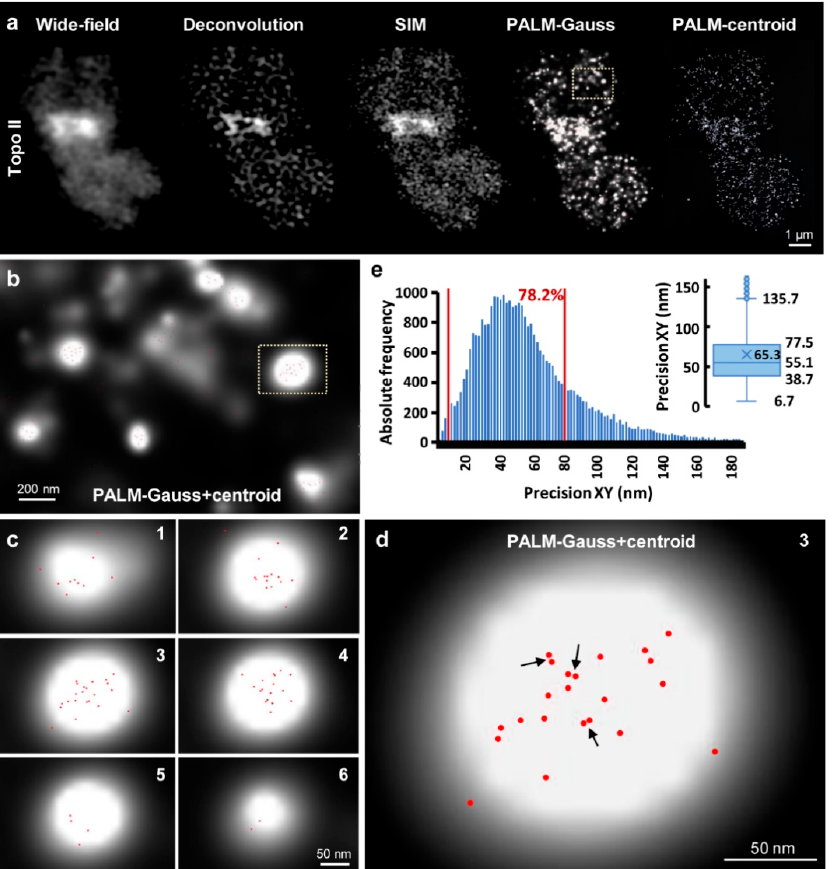
Figure 4. Photoactivated localization microscopy (PALM) allows detecting single Topo II molecules with an XY-precision of up to ~5 nm. ( a ) Visualization of Topo II by wide-field, deconvolution, SIM, and PALM using secondary Alexa488-labeled antibodies in a single 3D image stack slice. The PALM-centroid view indicates the localization of single molecules present in a single PALM image slice of 20 nm thickness. ( b ) Enlarged region (dashed rectangle in ( a ) showing the distinct accumulation of several molecules (indicated by centroids) within PALM-Gauss spots. ( c ) In the six consecutive slices of a further enlarged spot (dashed rectangle in ( b ) differently localized molecules per slice appear. The Z precision reached up to ~45–50 nm (see Figure S3). ( d ) In slice 3 centroid pairs even if ~5 nm apart (arrows) can be distinguished and hence Topo II molecules can be counted. ( e ) The diagram shows the 3D-PALM XY-localization precision of all molecules detected in the whole chromosome. 78.2% of the molecules were localized with a precision of 10–80 nm (region within both red lines). The inset shows the distribution (boxplot) of the lateral localization precision. Numbers indicate lower whisker (6.7 nm), 25% quantile (38.7 nm), median (55.1 nm), mean (65.3 nm), 75% quantile (77.5 nm), and upper whisker (135.7 nm). Localization precisions smaller than 5 nm occurred but were rare.